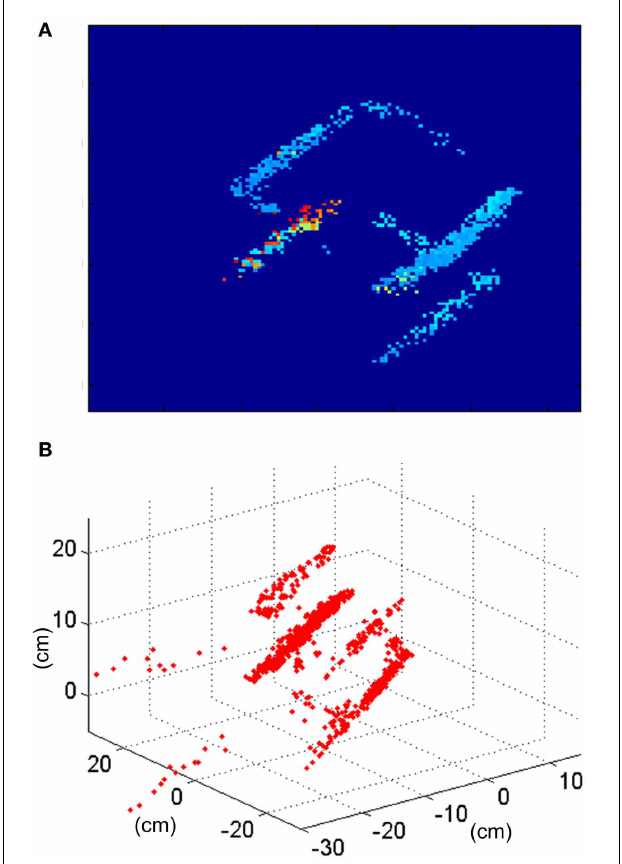
FIGURE 21 | Results obtained for the cube. (A) Disparity map reconstructed with T frame = 50 ms corresponding to the rotation of the cube. (B) Result of the 3D reconstruction of the same frame of the cube